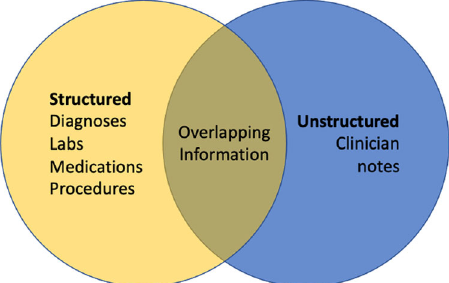
Fig. 1 Information overlap in EHR data. Electronic health records contain both structured and unstructured data. These two types of data contain both unique and overlapping information.